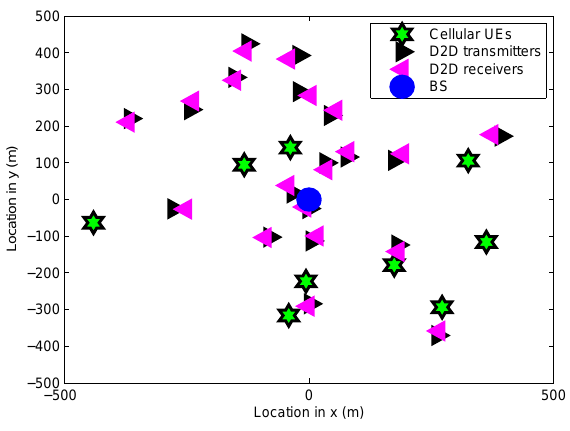
Figure 3: The average energy efficiency of D2D links corresponding to the number of game itera- tions ( N = 3 , K = 3 , M = 64 , p l = ˜ p l = 200 i,max k,max mW, R l = 0 . 1 bit/s/Hz, R l = 0 . 5 bit/s/Hz, i,min k,min 1000